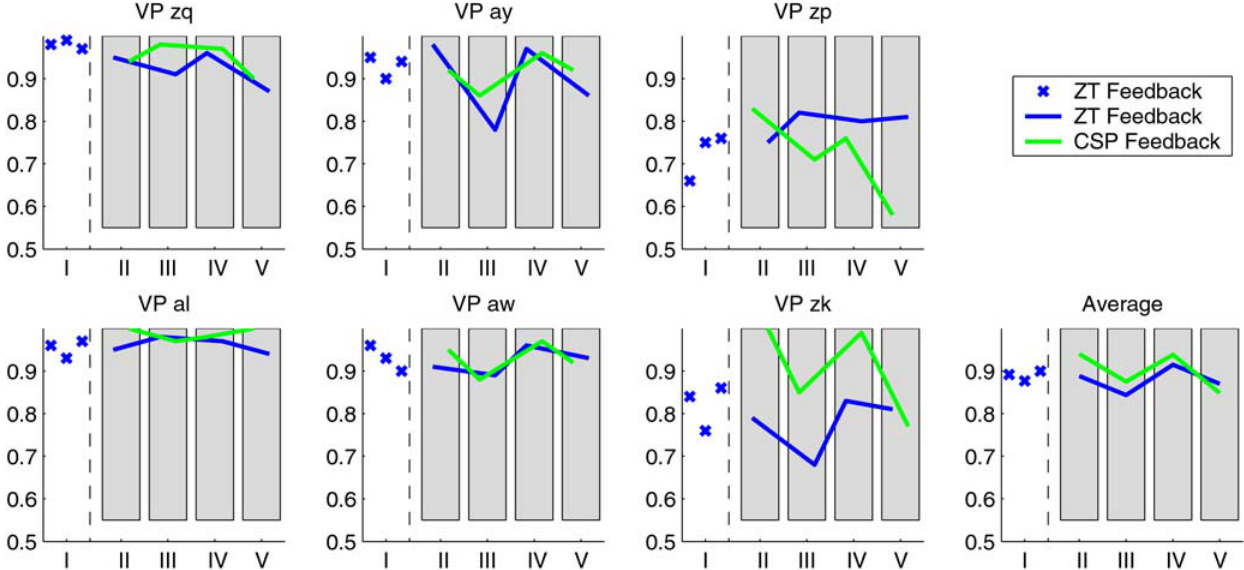
Figure 4. The feedback results for each of the six subjects. The feedback accuracy is denoted for the 100 trials of each run. The initial three runs, here marked as block ‘‘I’’, were done with the Zero-Training classifier, and in the following the order of the classifiers was randomly permuted in each block of two runs, here denoted as ‘‘II–V’’. The shift of the blue curve relative to the green curve within the shaded areas indicates the order of the classifiers within the block.